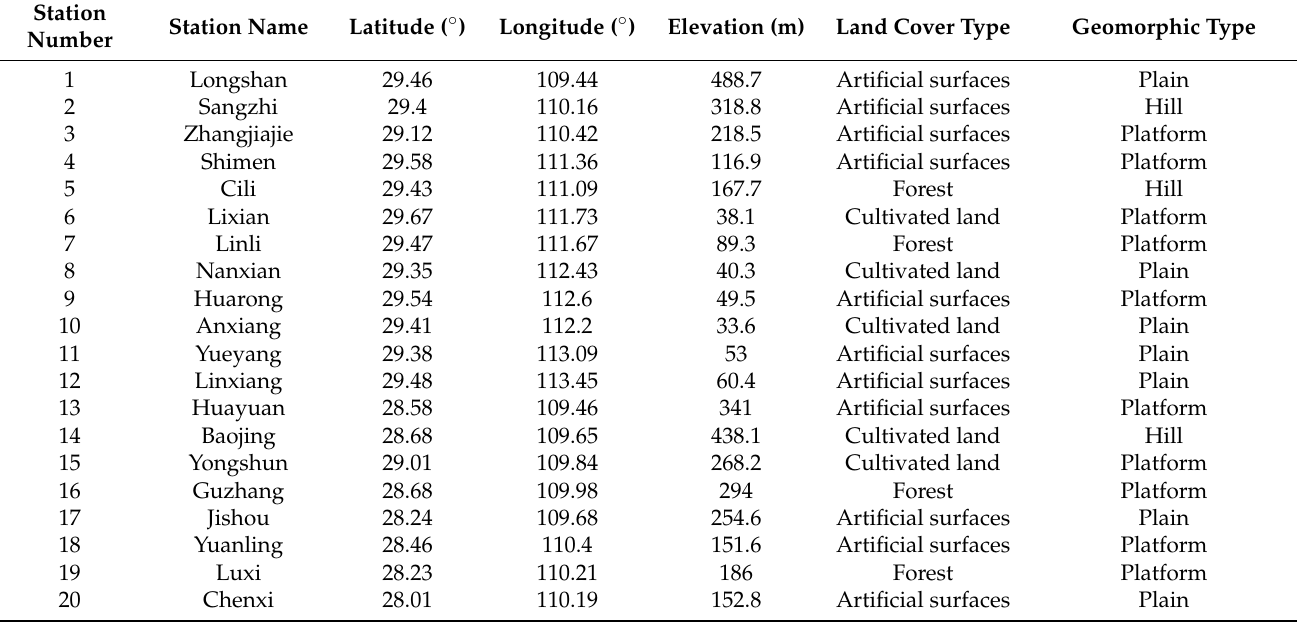
Table A1. Overview of in situ measured